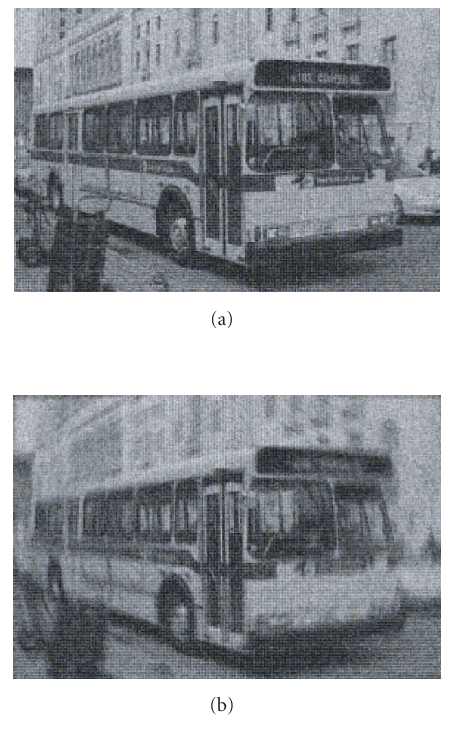
Figure 10: (a) Decryption of Haar wavelet compressed shares; (b) decryption of unregistered Haar wavelet compressed shares.